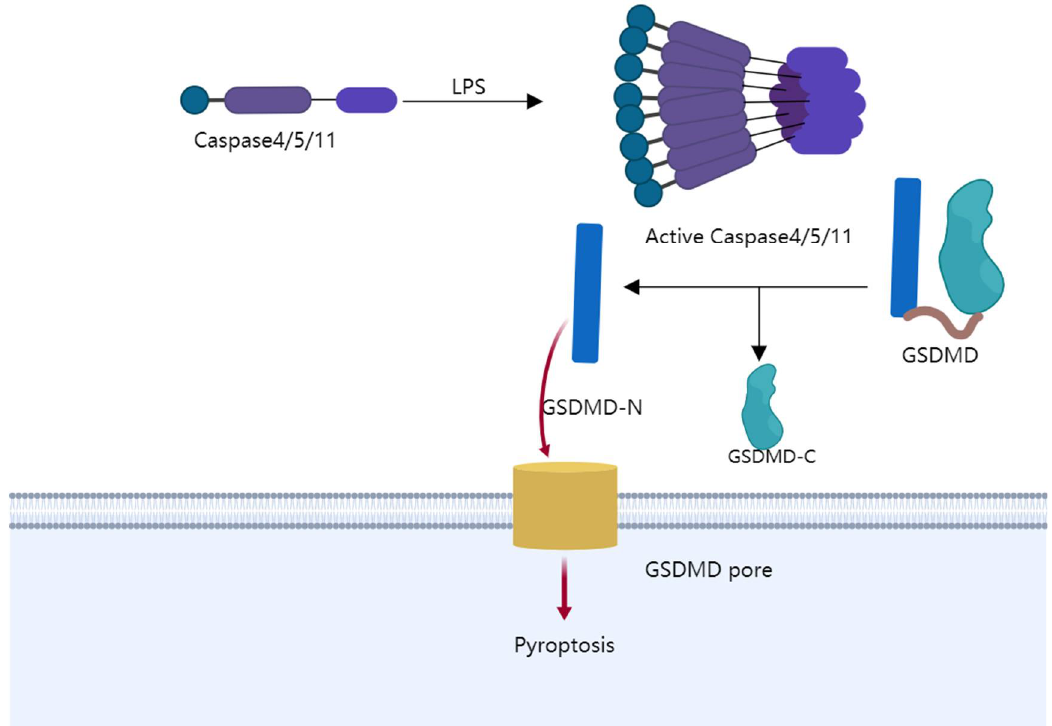
Figure 3. Schematic diagram of pyroptosis pathway.